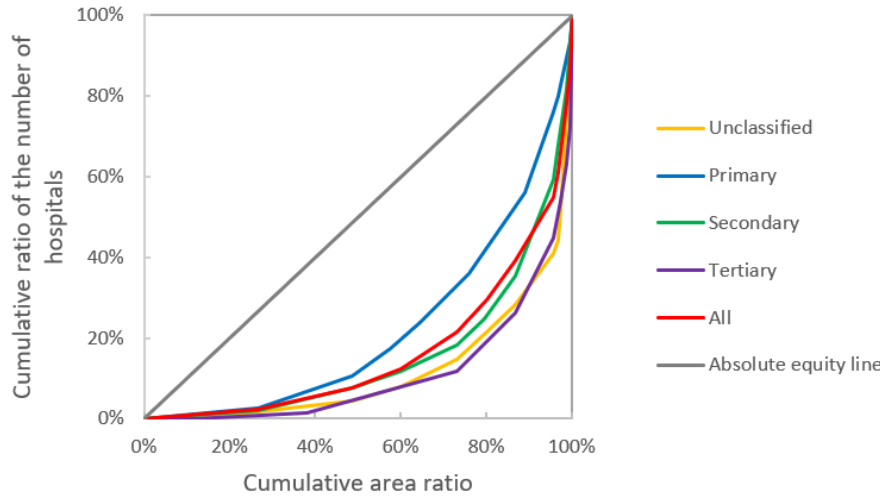
Figure 5. Lorenz curve for different levels of medical institutions by geographical area.